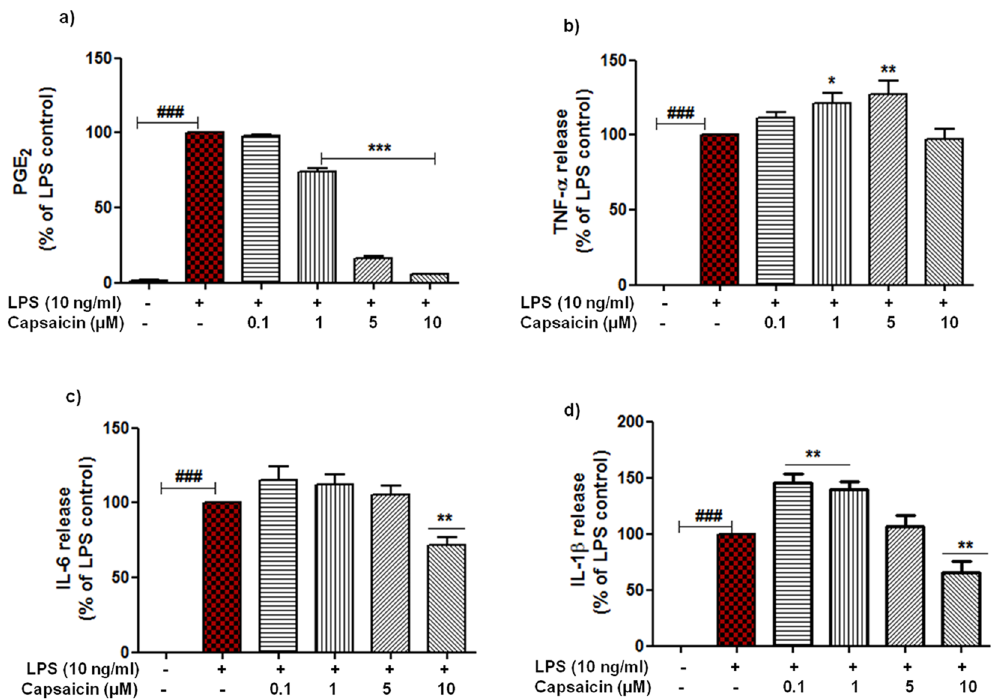
Figure 3. Regulation of inflammatory markers by capsaicin (cap) in activated primary human peripheral blood monocytes. Monocytes were pre-treated with cap (0.1–10 µ M) for 30 min, afterwards cells were incubated with or without LPS (10 ng/ml) for the next 24 h. At the end of incubation, cell supernatants were collected, centrifuged and release of PGE 2 ( a ), TNF- α ( b ), IL-6 ( c ) & IL-1 β ( d ) were measured. Statistical analyses were carried out by using one way ANOVA with post hoc student Newman-Keuls test (Multiple comparisons). Results are expressed as means ± SE of 5 independent experiments. # p < 0.05; ## p < 0.01; ### p < 0.001 compared with control cells. * p < 0.05; ** p < 0.01; *** p < 0.001 compared with LPS (10 ng/ml) activated